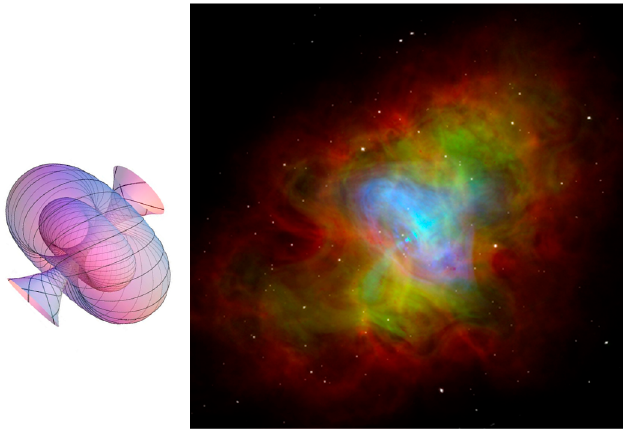
Figure 4. Comparison between the Hopf foliation ( left ) and a combined X-rays and infrared image of the Crab Nebula after a supernova explosion ( right ).